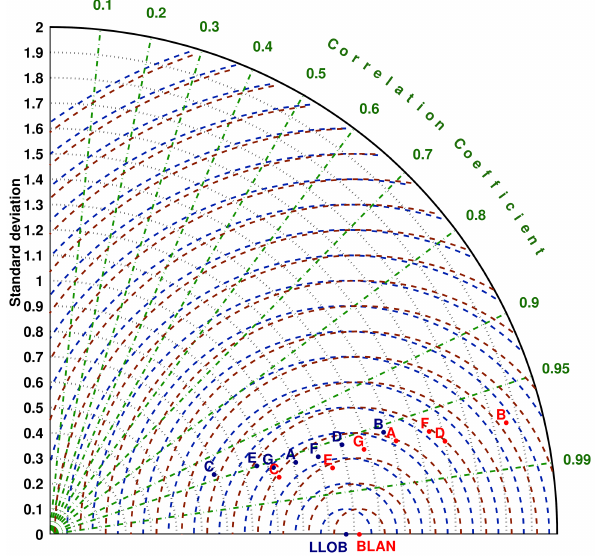
Figure 7. Hydrodynamic sensitivity analysis schematized in a Tay- lor diagram. Green lines represent the correlation coefficient. Blue semicircles represent the CRMSD error for the Llobregat buoy. Red semicircles represent the CRMSD error for the Blanes buoy. The radius is proportional to the CRMSD, representing a 0.1 unit each step. Red (Blanes buoy) and blue (Llobregat buoy) dots come from the sensitivity analysis. Point legend: A (Original wind field), B ( + 20%), C ( − 20%), D ( + 10%), E ( − 10%), F ( + 5%) and G ( − 5%). All perturbations refer to the wind driving (for initial or base state, see